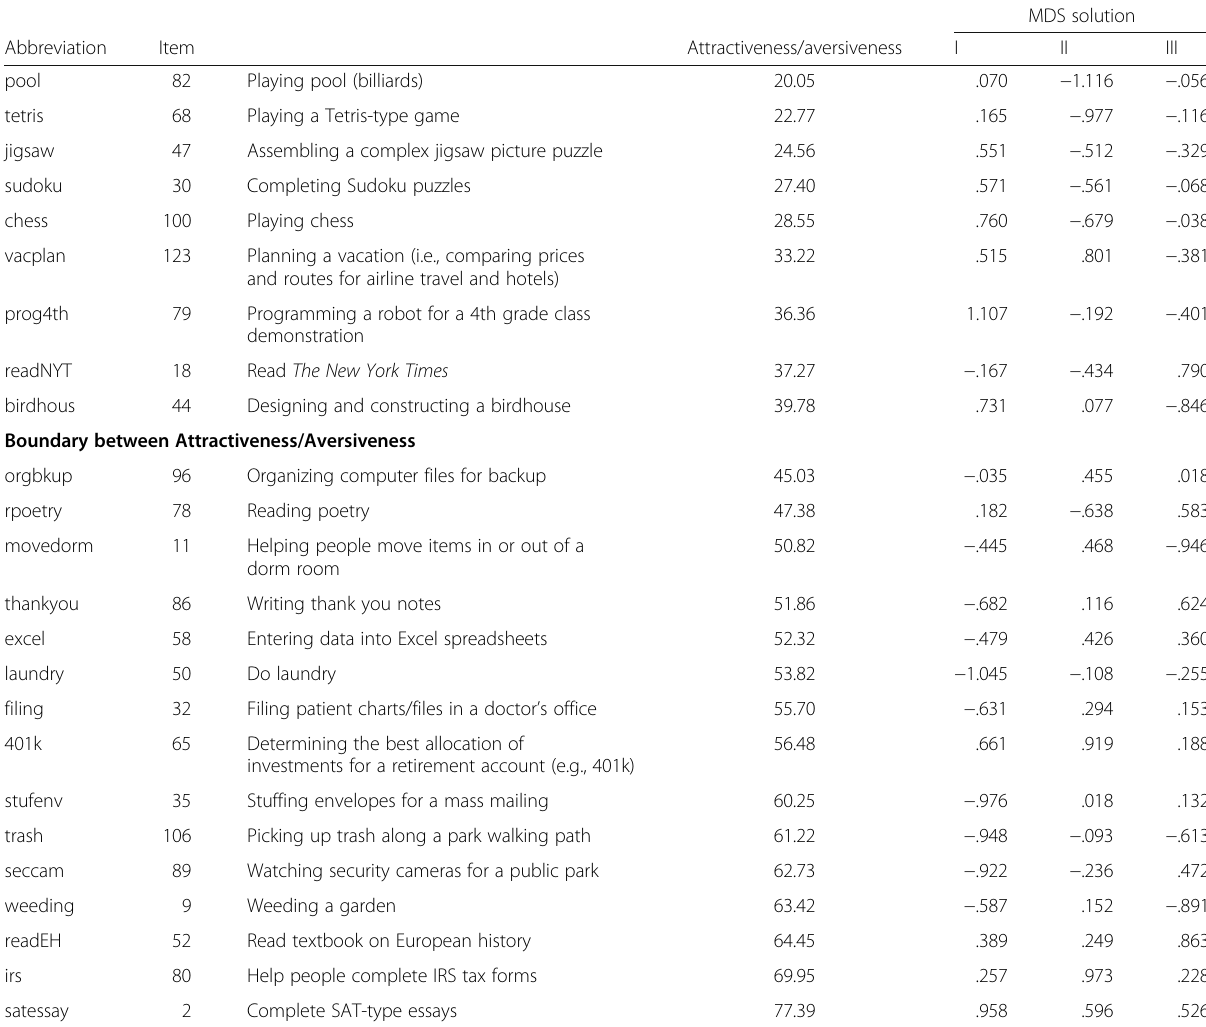
Table 2 Multidimensional scaling (3D) of similarity judgment items (ordered by attractiveness/aversiveness, from preference